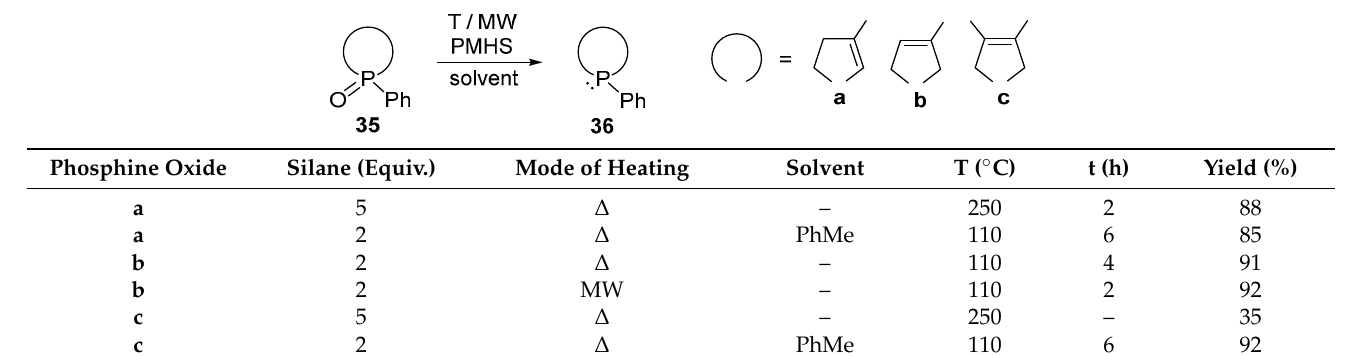
Table 15. MW ‐ assisted Hirao reaction of bromoarenes and diethyl phosphite applying Pd(OAc) 2 as the catalyst precursor.